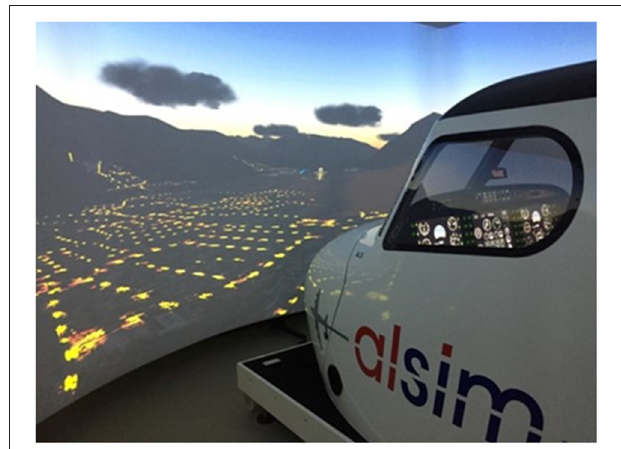
FIGURE 2 | The CQ Stab 2P two-plates platform, made by CQ Elektronik, Poland ( 44).